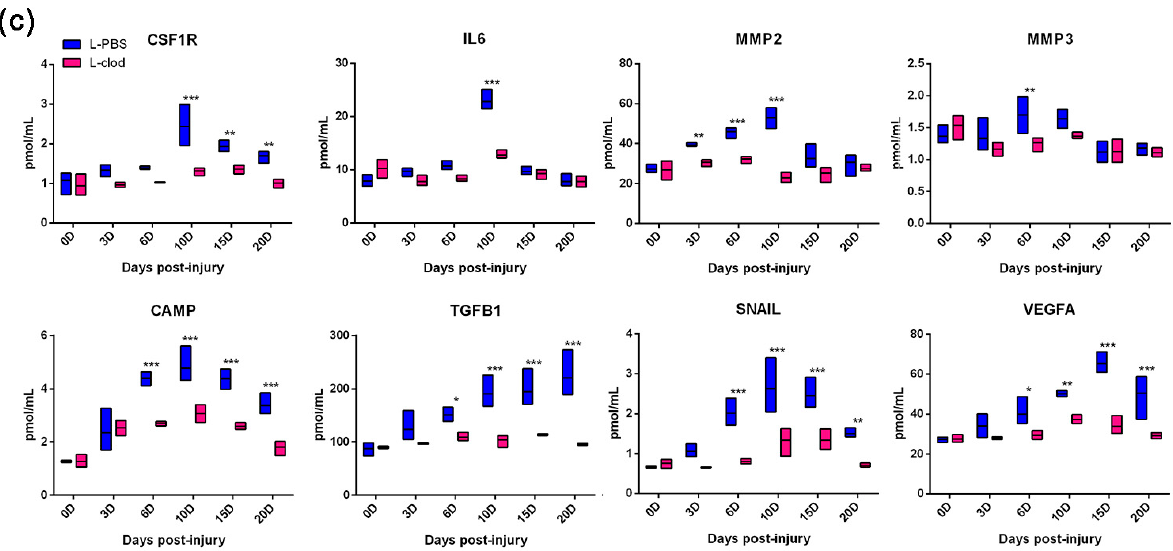
Figure 4. Gene and protein expression profiles of mice after treatments during wound healing process. Changes in gene expressions at different time points were assessed by RTq-PCR. ( a ) The histogram shows relative mRNA expression levels at 3D and was normalized to those of α -ACTIN mRNA levels, then to similarly normalized values for 0D tissues. Primer sequences used are listed in Materials and Methods ( b ) Line graphs represent expression profile changes between L-clod- and L-PBS-treated groups. ( c ) Changes in protein expression at different time points were assessed by ELISA and were represented in dot plots (line at mean). All data are presented as mean ± SD ( n ≥ 3. * p < 0.05, ** p < 0.01, *** p < 0.001.).